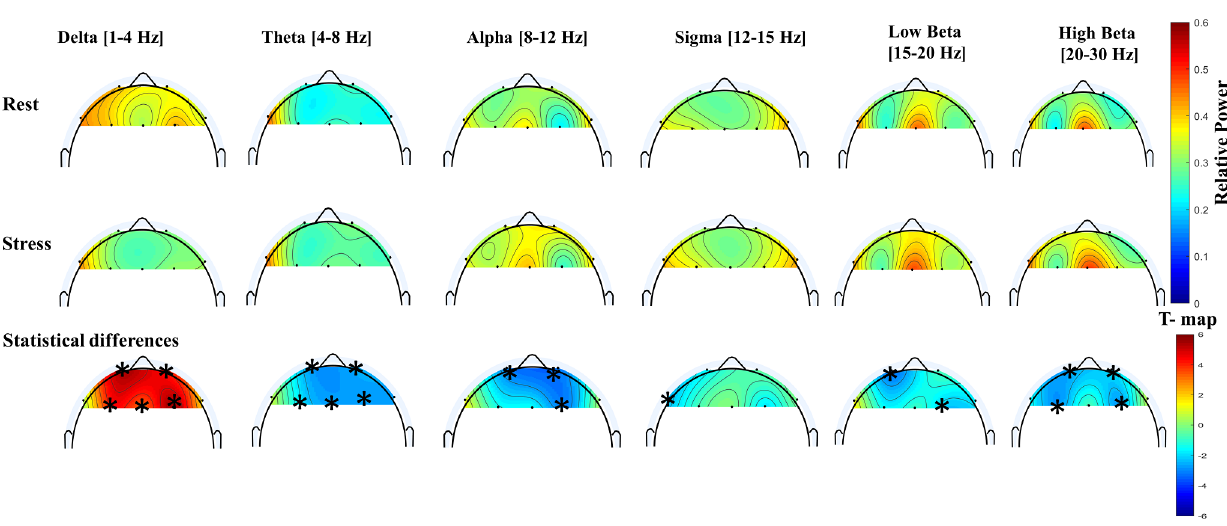
Figure 6. The mean topographic maps for relative bands power of delta, theta, alpha, sigma, low beta, and high beta at 1–30 Hz for rest and stress conditions. The difference between stress and rest relative powers are shown using T- maps. The star (*) symbols denote to the significant electrodes related to specific feature (two-sample t -test; p < 0.01, Bonferroni